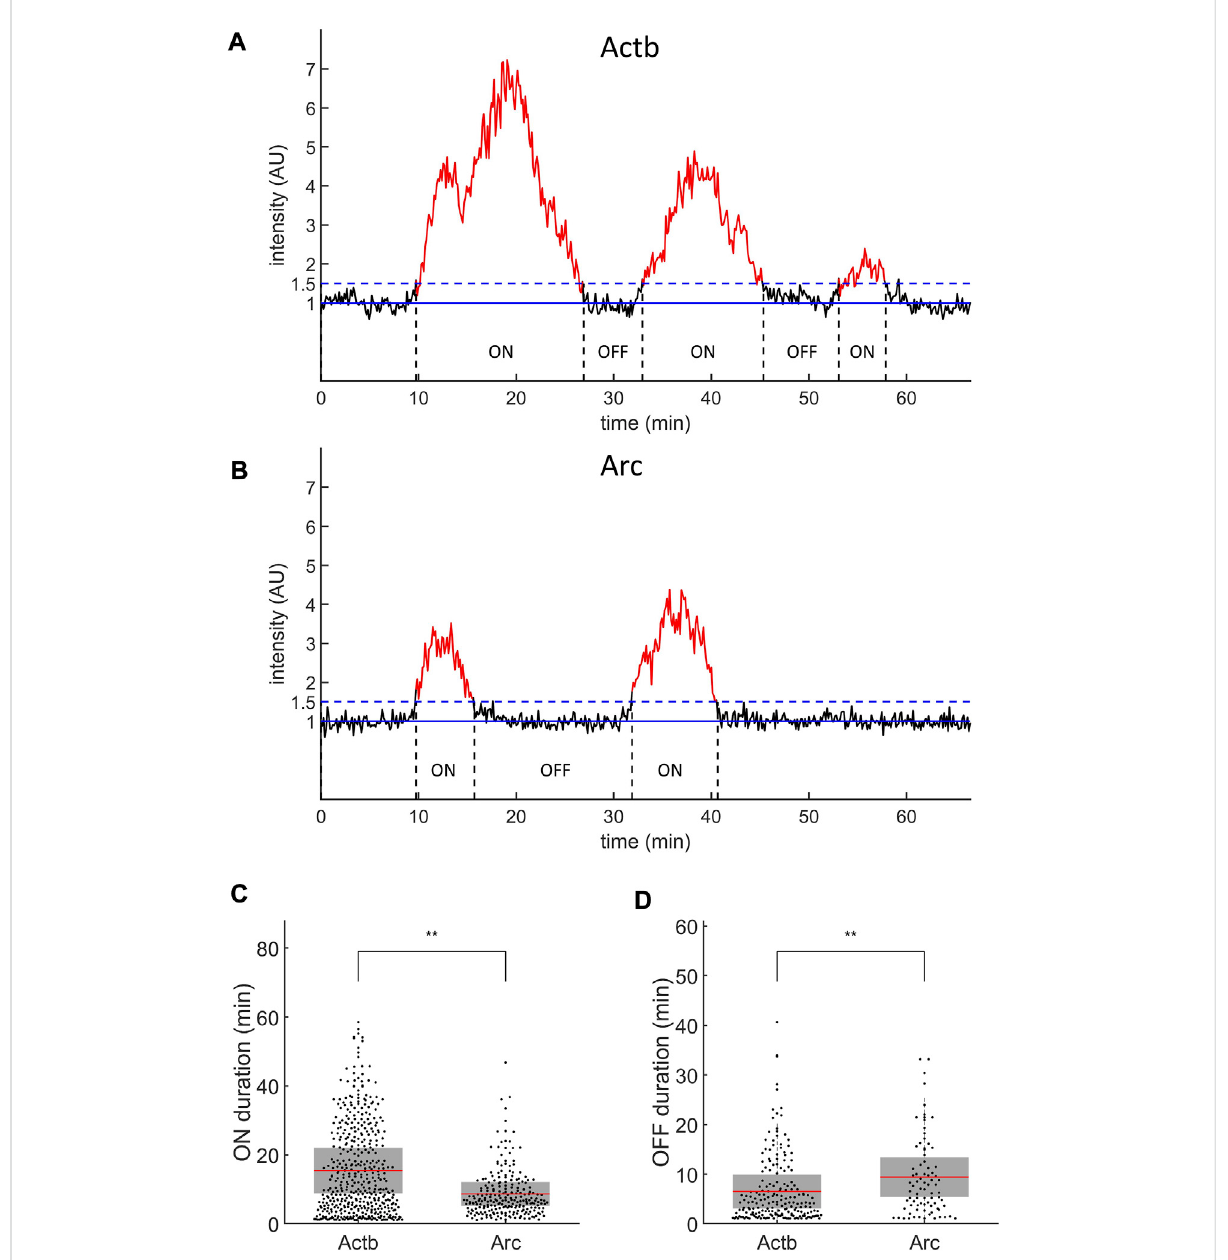
FIGURE 5 Transcription ON and OFF durations of Actb and Arc genes. (A,B) Representative intensity pro fi les of transcription sites of Actb (A) and Arc (B) genes. The solid blue lines indicate the baseline normalized by the nuclear background. The dashed blue lines indicate the threshold for transcriptionalON(red)andOFF(black)states. AU,arbitraryunits. (C,D) ON (C) andOFF (D) durationsofActb(n=449forONand198forOFFstates) and Arc (n = 234 for ON and 83 for OFF states). The mean (red line) and standard deviation (SD, gray box) values are indicated (* P < 0 . 05 and ** P < 0 . 01, Wilcoxon rank-sum